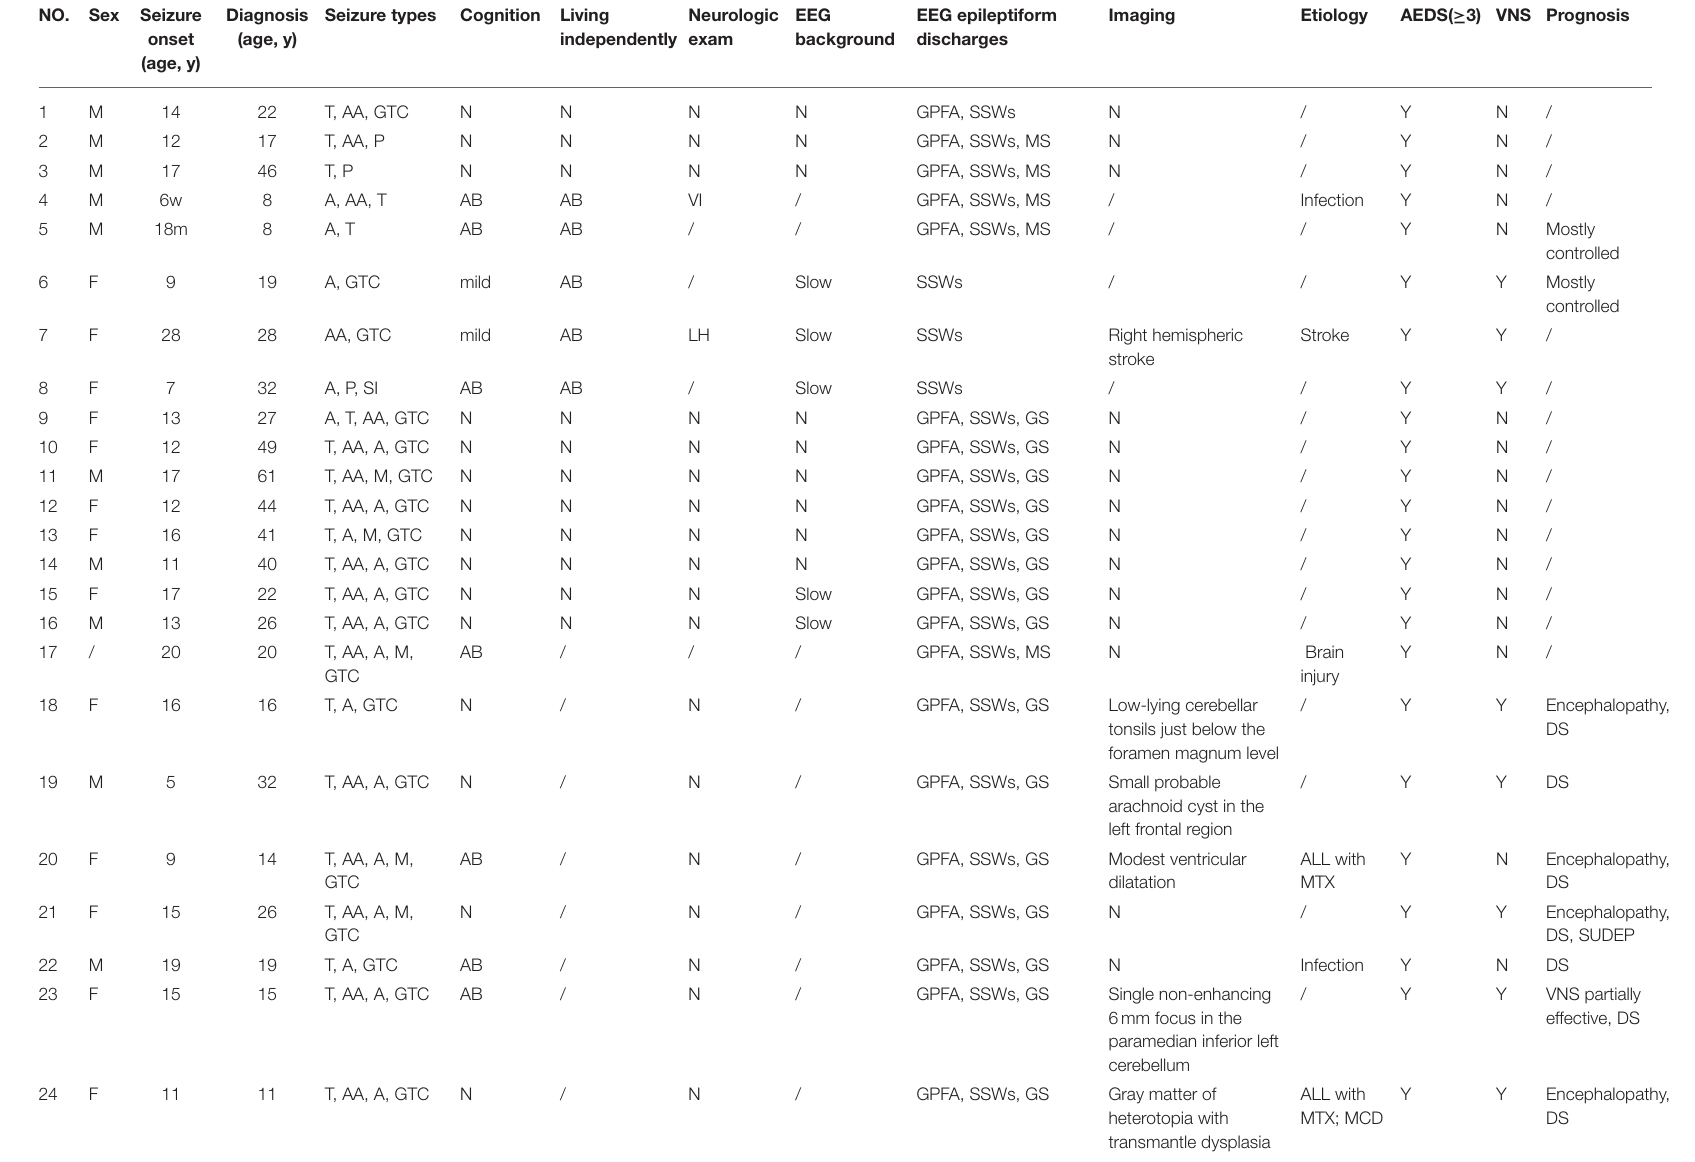
TABLE 1 | Clinical characteristics, EEG and imaging findings, and other case details in 42 cases of late-onset Lennox-Gastaut Syndrome (LGS). NO. Sex Seizure